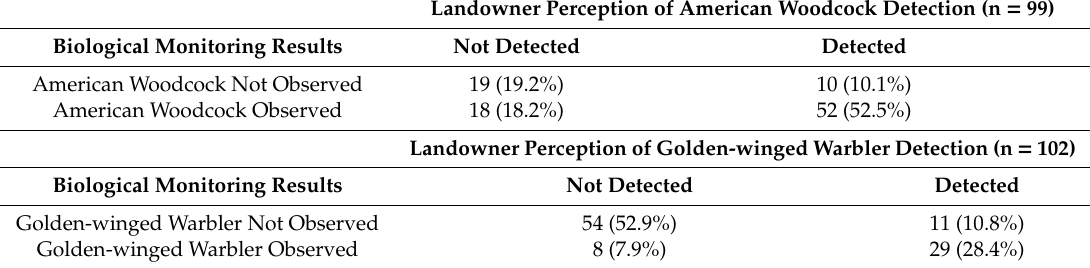
Table 1. Cross-tabulation of landowner perception of target species detection on their property and target species presence determined by biological monitoring, eastern United States, February–May 2017.